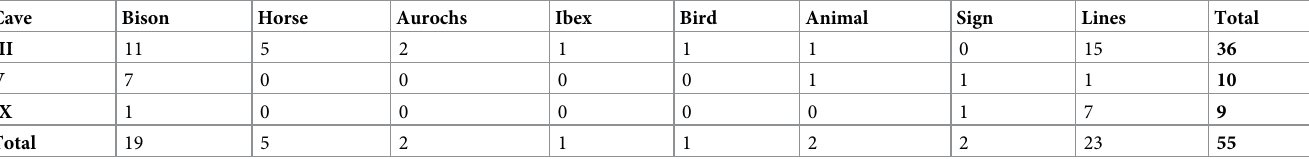
Table 2. Graphic units in the Gravettian representations in Aitzbitarte Caves III, V and